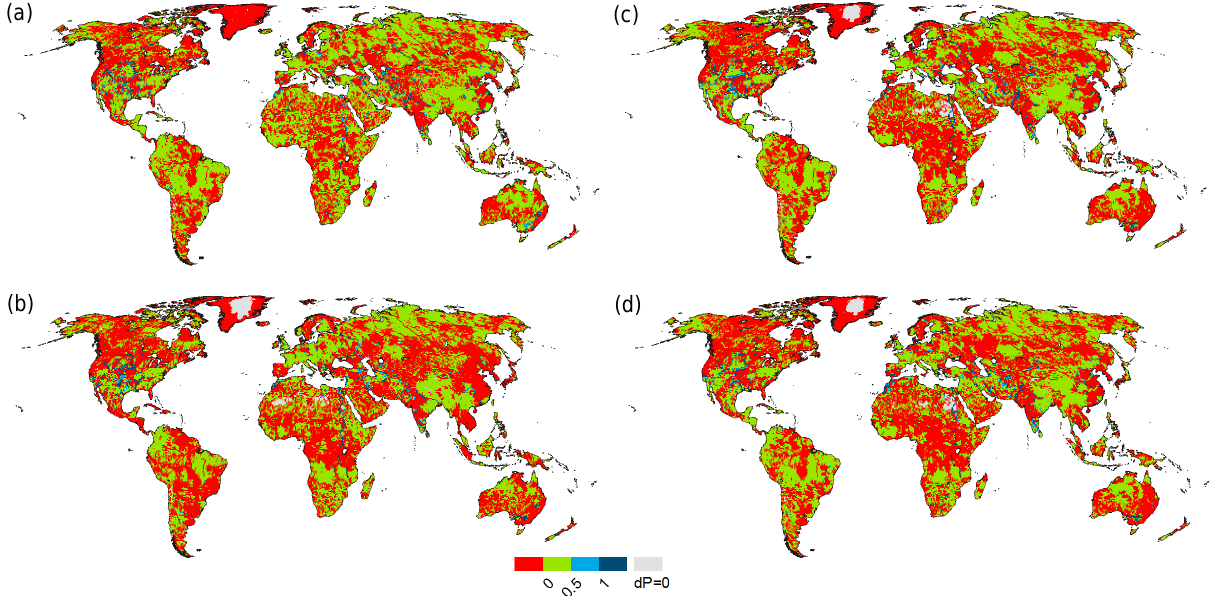
Figure B3. Indicator B n quantifying the relative dominance of anthropogenic impact on Q change (i.e., Q − Qnat ) as compared to the change in Q (Eq. 5) from 1911–1940 to 1941–1970. Grey color indicates that the change in Q is zero, such that B n cannot be computed. Red color indicates areas where B n is less than 0, and the change in anthropogenic impact is not consistent with the change in Q ; therefore, the anthropogenic impact is not the dominant driver for change in Q . Results are shown for WaterGAP as driven by the climate forcings